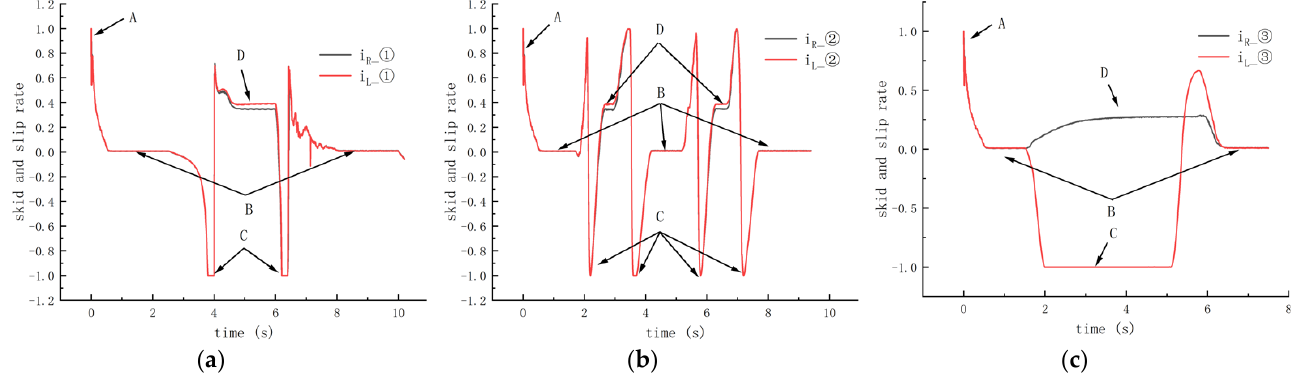
Figure 8. Angular obstacle-avoidance steering simulation. ( a ) Obstacle-avoidance steering motion shown in scheme 1 (10.2 s); ( b ) Obstacle-avoidance steering motion shown in scheme 2 (9.4 s); ( c ) Obstacle-avoidance steering motion shown in scheme 3 (7.5 s).